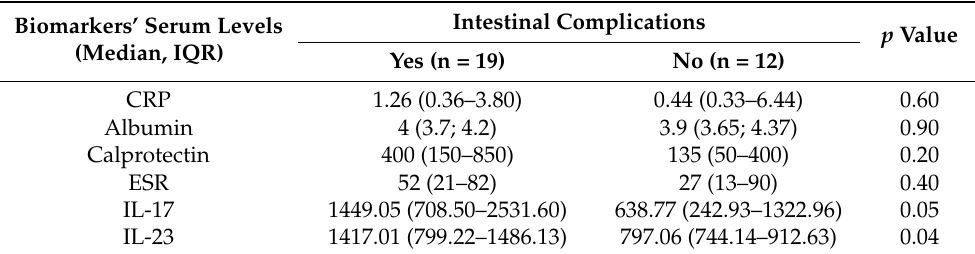
Table 3. IL-17, IL-23, and standard inflammatory biomarker levels in patients with or without CD-related